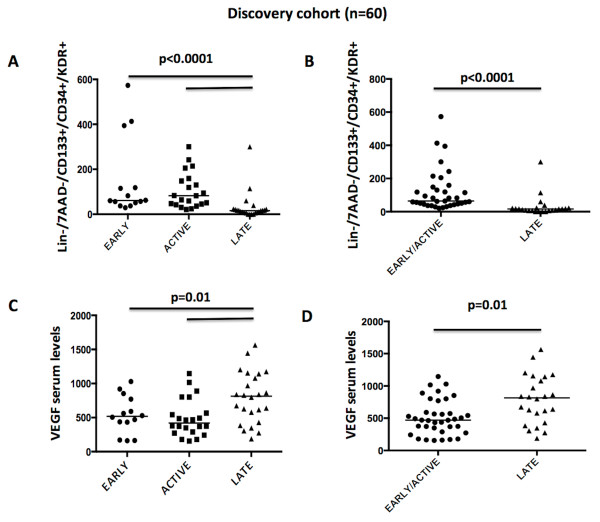
Levels of circulating endothelial progenitor cells (Lin-7AAD-CD133+CD34+VEGFR2+ cells) (A, B) and VEGF serum levels (C, D) in the discovery cohort according to the nailfold videocapillaroscopy pattern.